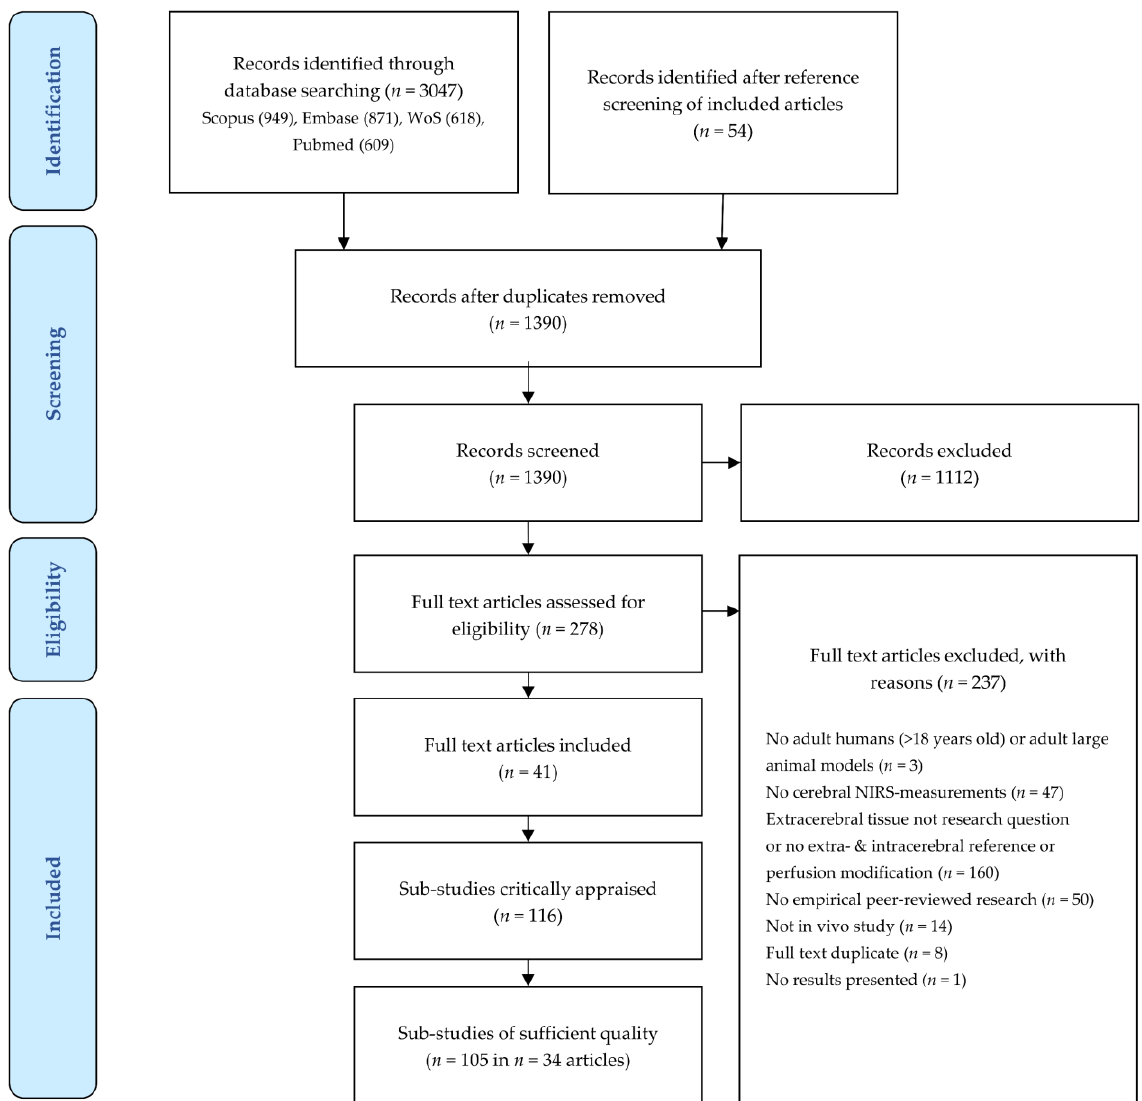
Figure 1. Screening process. Screening followed the Preferred Reporting Items for Systematic Reviews and Meta-Analysis of Diagnostic Test Accuracy Studies (PRISMA-DTA) Statement [14]. Exclusion of full text articles was possible based on multiple criteria. Sub-studies of sufficient quality are those for which more than 50% of the QUADAS-2 domains are assessed as ‘Low Risk of Bias’. NIRS, near-infrared spectroscopy; QUADAS-2, Quality Assessment of Diagnostic Accuracy Studies, revised second version; WoS, Web of Science. Figure adapted from Moher and colleagues, with permission [22].